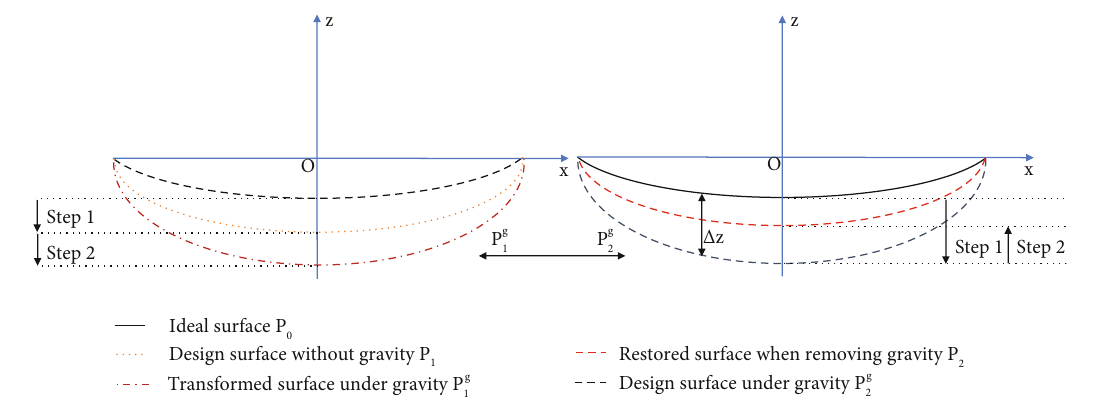
Figure 2: The comparison between two pretension design methods. (a) General method. (b) Method in this paper. The deviation between P g 1 and P g 2 increases as the antenna aperture